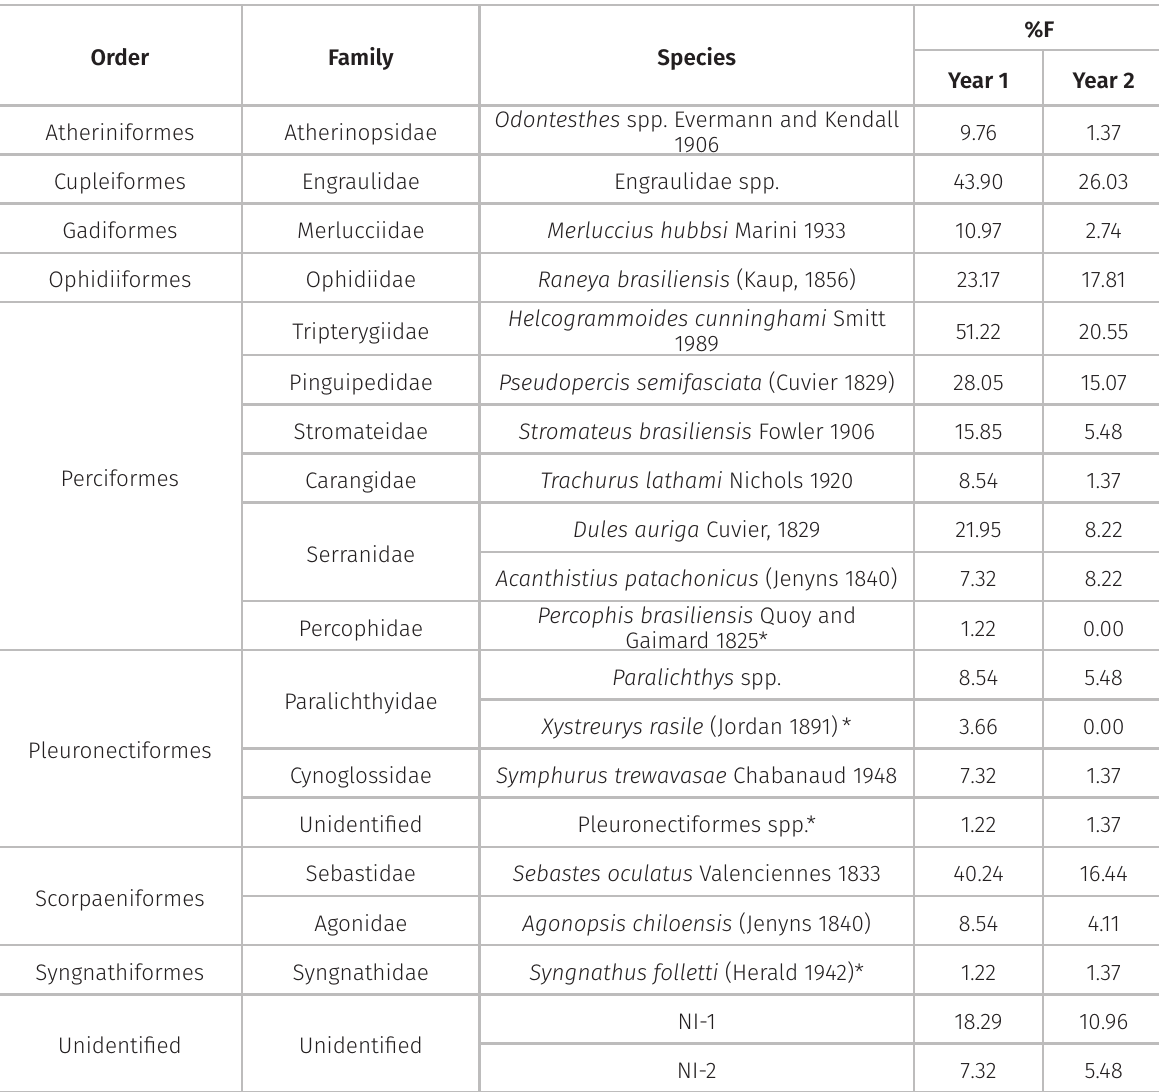
Table II. Larvae collected in the San José Gulf between October 2011 and March 2012 (Year 1), and between October 2012 and March 2013 (Year 2). %F: Frequency of occurrence (percentage of tows containing each species). * Identified species removed from the analyses due their low %F